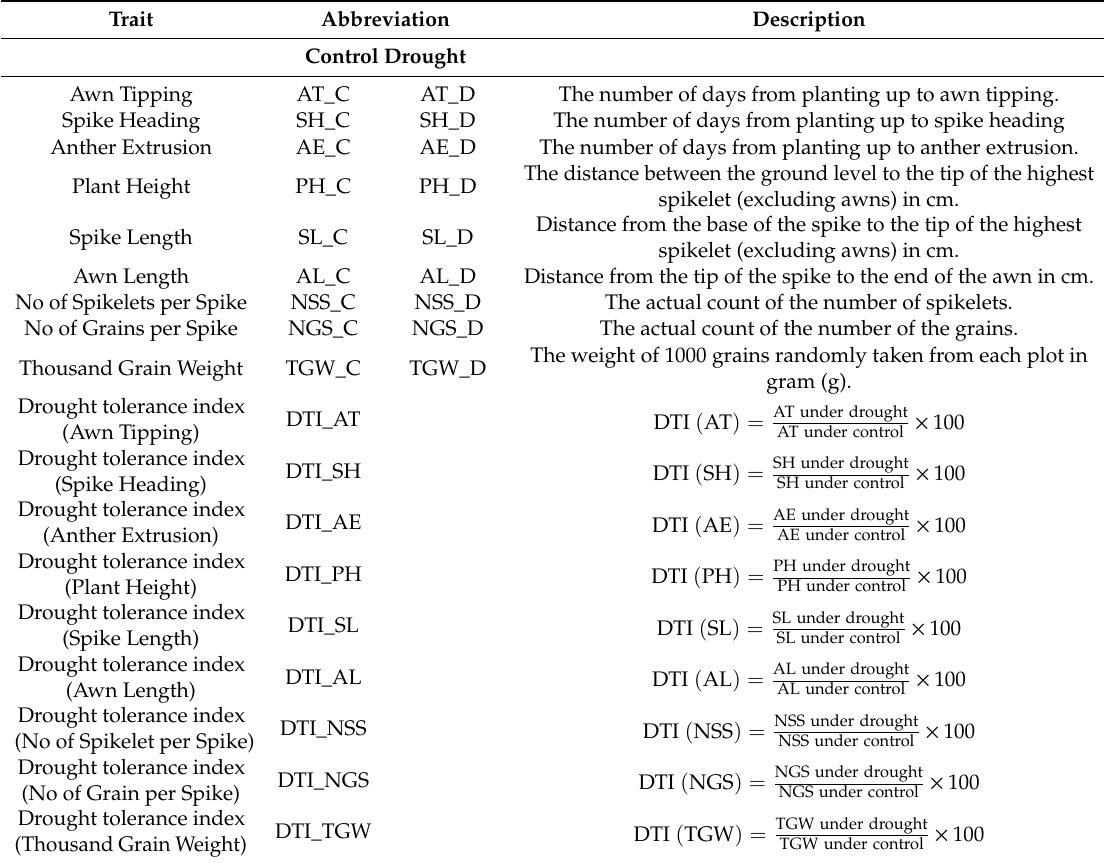
Table 1. The name and abbreviation of measured traits and respective description of measurements.